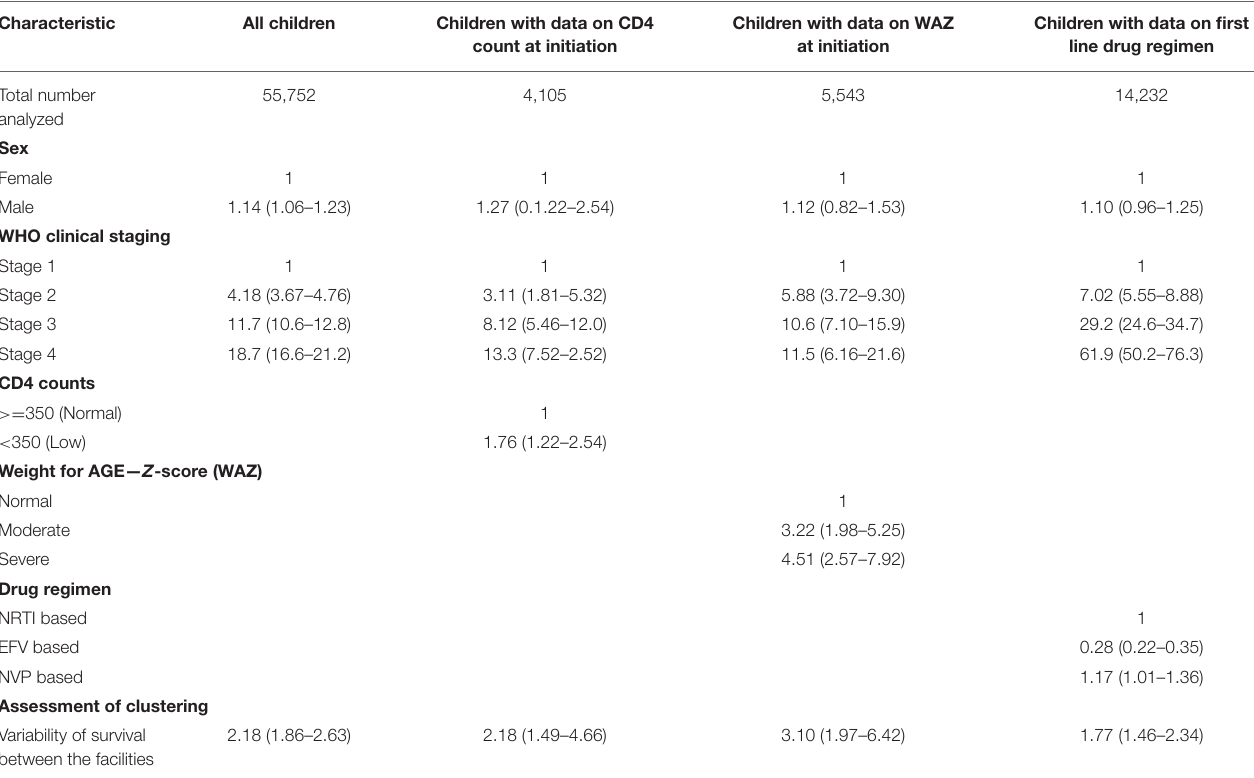
TABLE 4 | Multi level adjusted and unadjusted hazards ratios for factors associated with mortality among CLHIV on ART in Zambia clustered at facility level. Characteristic All children Children with data on CD4